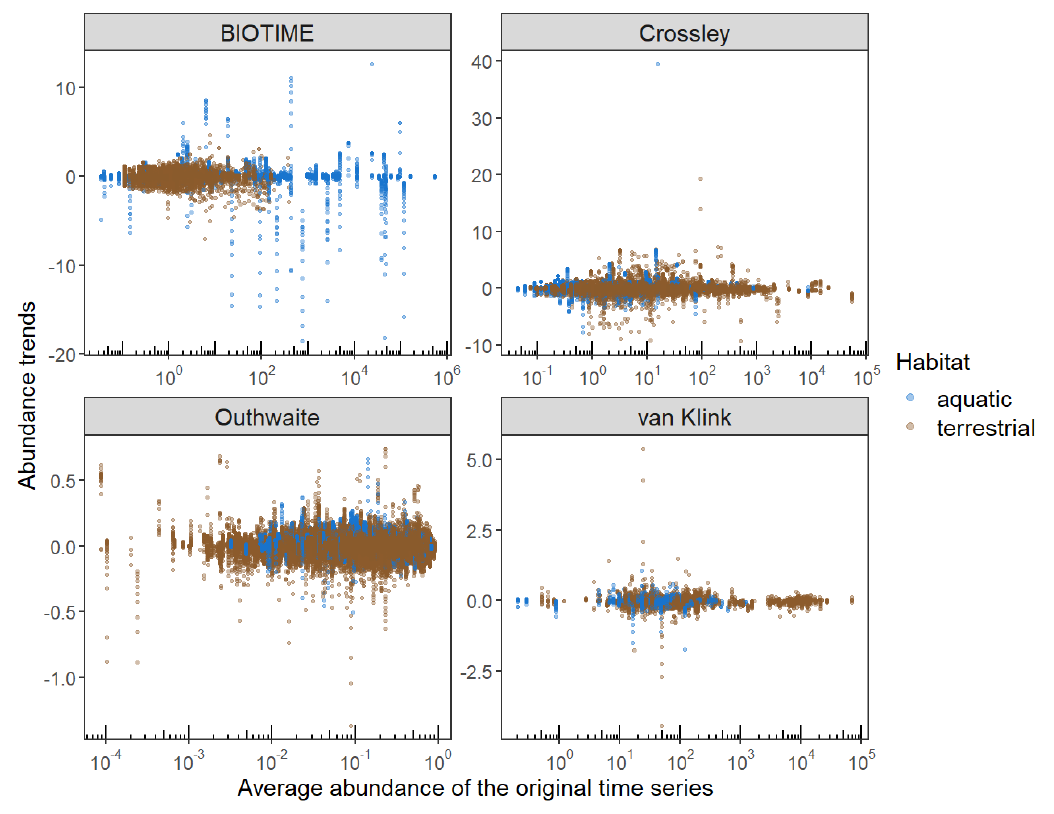
Figure S9: Estimated abundance trends of truncated time series as a function of average abundance. Abundance trends (log growth rate) as a function of the average abundance of the original time series (measured on the original abundance scale), per source dataset and